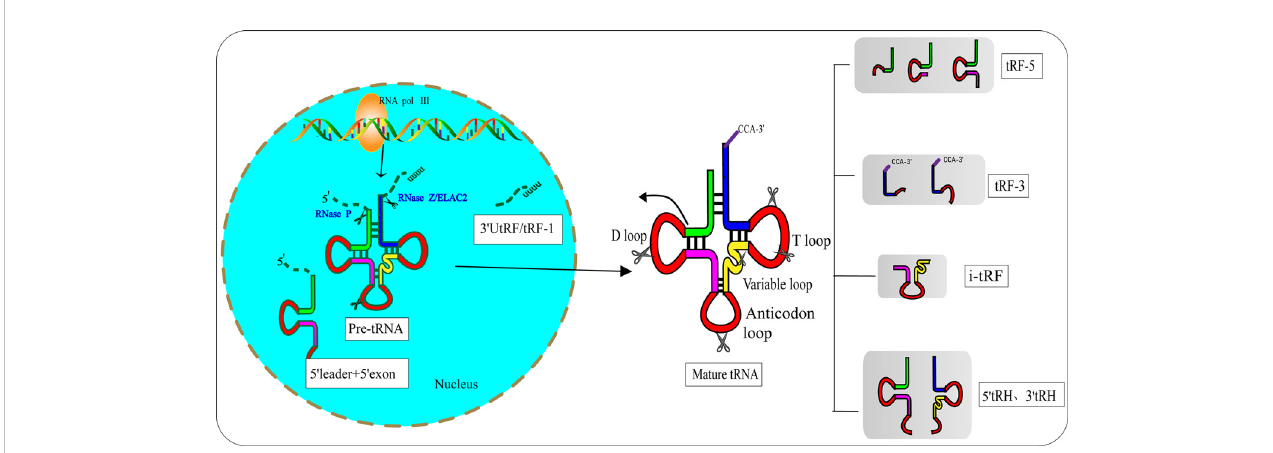
FIGURE 1 Biogenesis and classi fi cation of tRNA-derived fragments (tRFs). Pre-tRNA is transcribed by RNA Pol III in the nucleus and undergoes 5 ′ -leader, 3 ′ -polyU removal and 3 ′ CCA addition, based on disparate cleavage sites on pre-tRNA or mature tRNA. tRFs can be divided into different types including 3 ′ U tRFs (tRF-1s), 5 ′ -tRFs, 3 ′ -tRFs, i ′ -tRFs, 5 ′ -tRNA halves (5 ′ -tRHs) and 3 ′